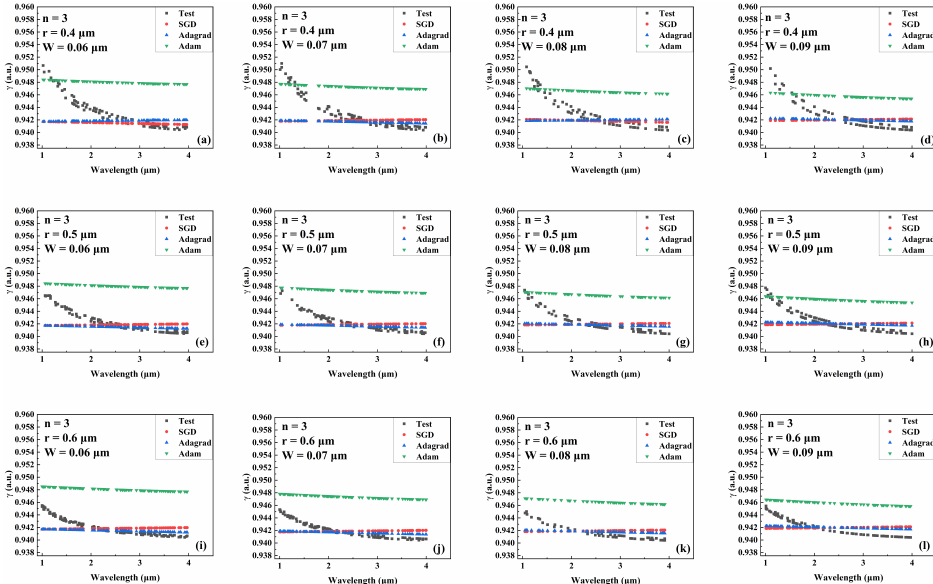
Figure 8. Comparison the predicted and actual values of γ in the test data set of the network model trained by different optimizers for different combinations of core radius and cantilever width (number of cantilevers: 3). ( a ) r = 0.4 µ m, W = 0.06 µ m. ( b ) r = 0.4 µ m, W = 0.07 µ m. ( c ) r = 0.4 µ m, W = 0.08 µ m.